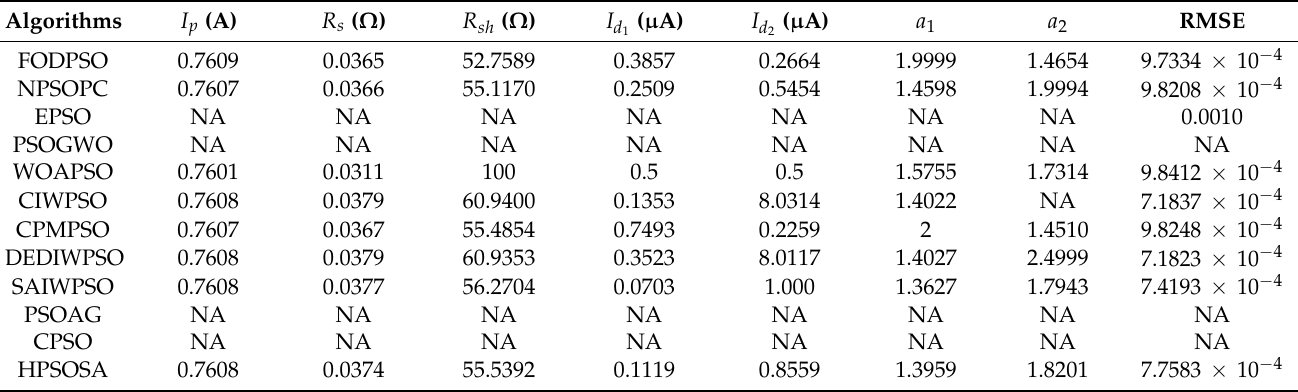
Table 5. Comparison of hybrid PSO algorithms for parameter estimation of RTC France solar cell (double diode